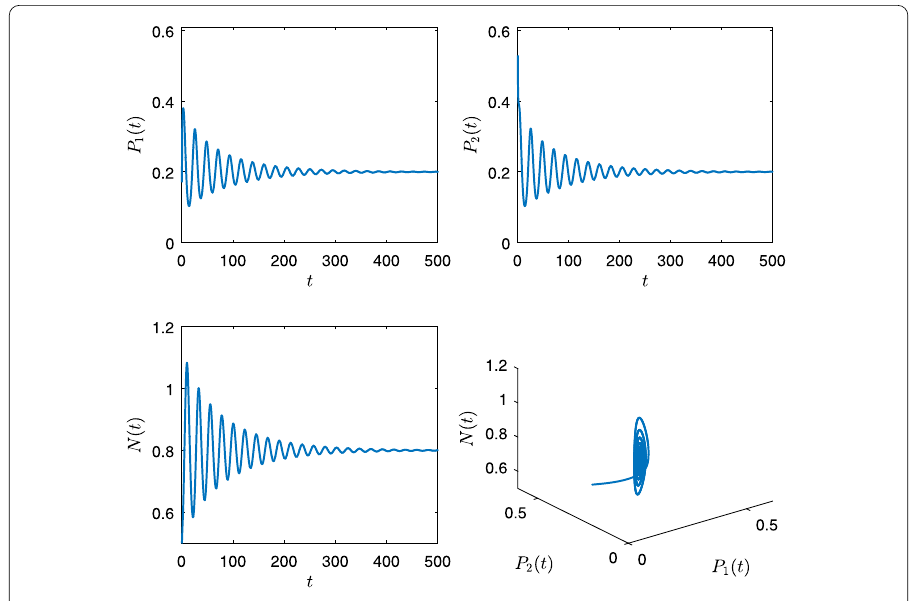
Figure 1 E † of system (34) is stable by choosing τ = 2.0 < τ 0 =